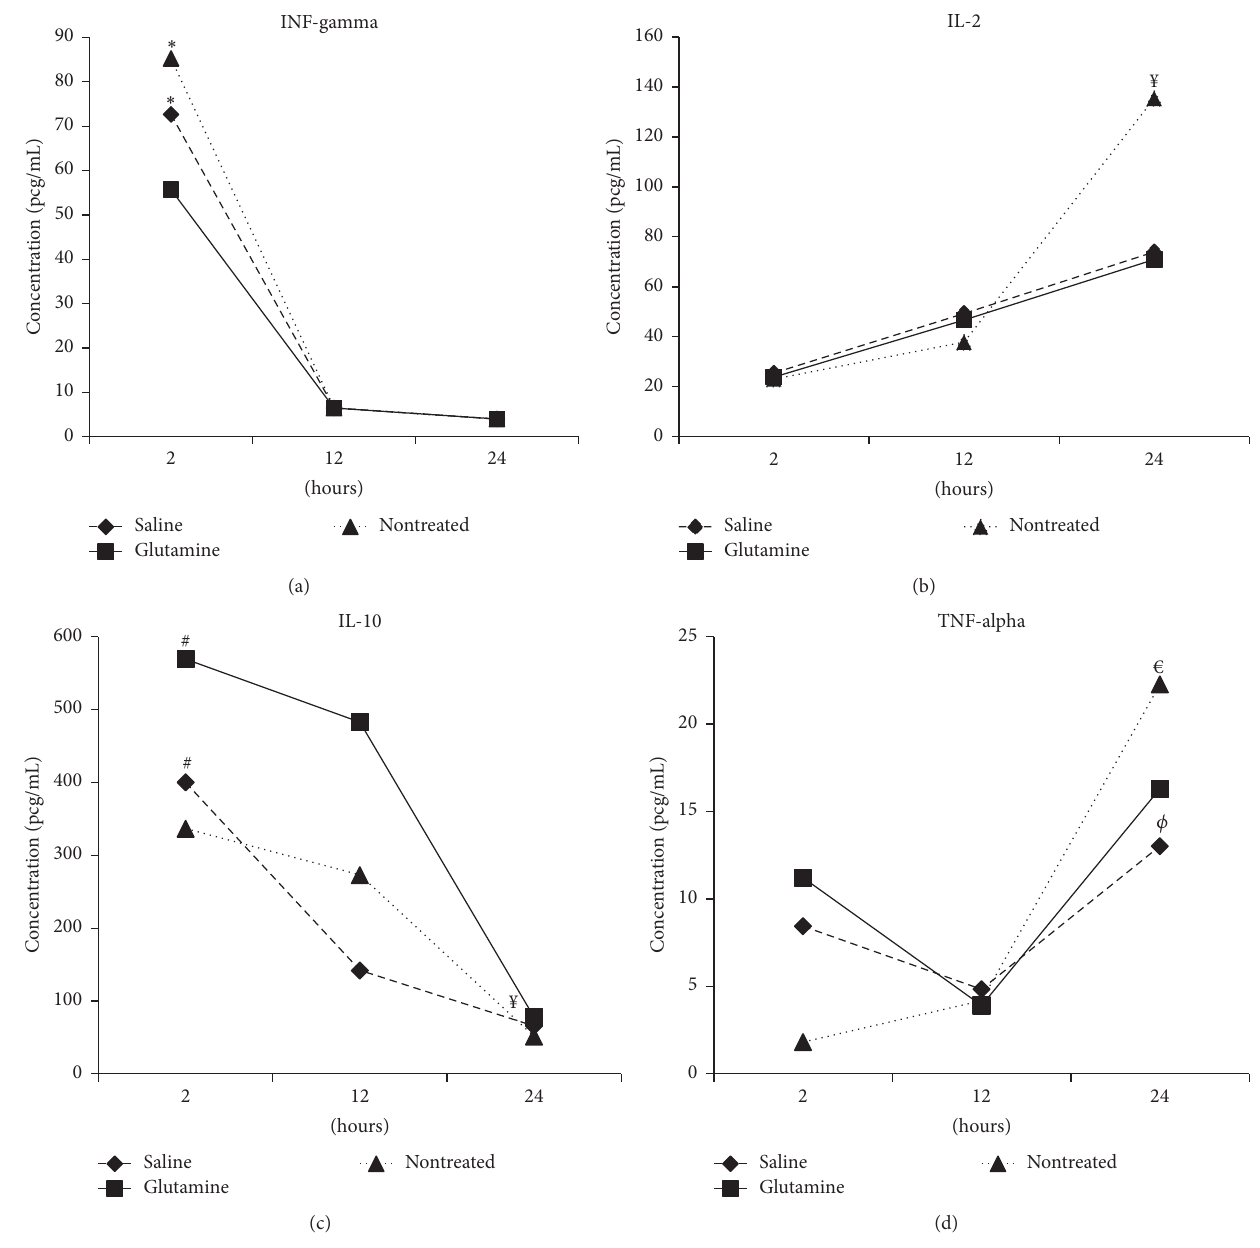
Figure 1: Median serum concentrations of interferon- (IFN-) gamma (a), interleukin- (IL-) 2 (b), IL-10 (c), and tumor necrosis factor- (TNF-) alpha (d) at 2, 12, and 24 h after acute pancreatitis induction with sodium taurocholate in Lewis rats previously treated or not treated with 48 h infusion of parenteral saline or glutamine. ∗ 𝑝 ≤ 0.050 versus 12 and 24 h; ¥ 𝑝 ≤ 0.050 versus 2 and 12 h; # 𝑝 ≤ 0.050 versus 24 h; € 𝑝 = 0.051 versus 2 and 12h; 𝜙 𝑝 = 0.060 versus